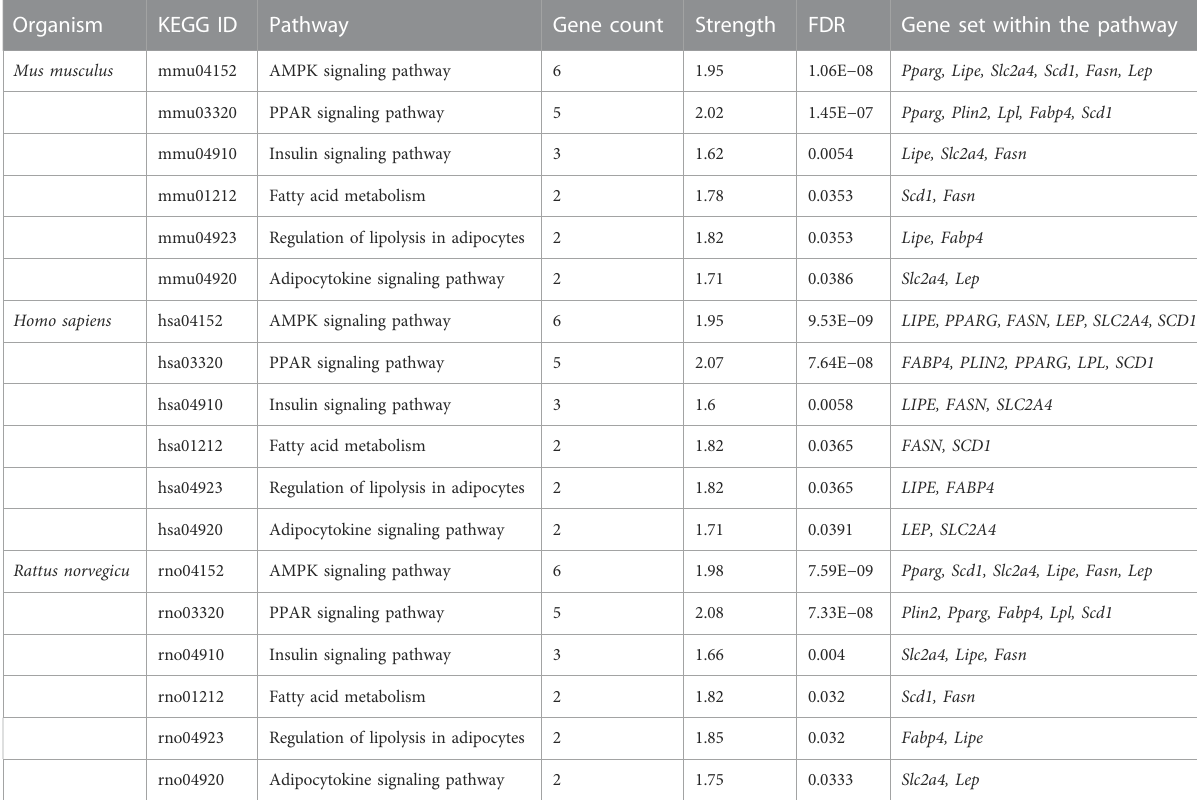
TABLE 3 Gymnemagenin-modulated 12-gene enrichment analysis in Mus musculus , Homo sapiens, and Rattus norvegicus .